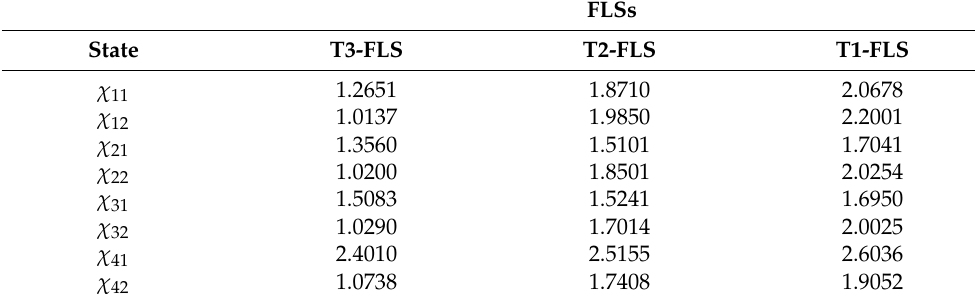
Table 3. Comparison of